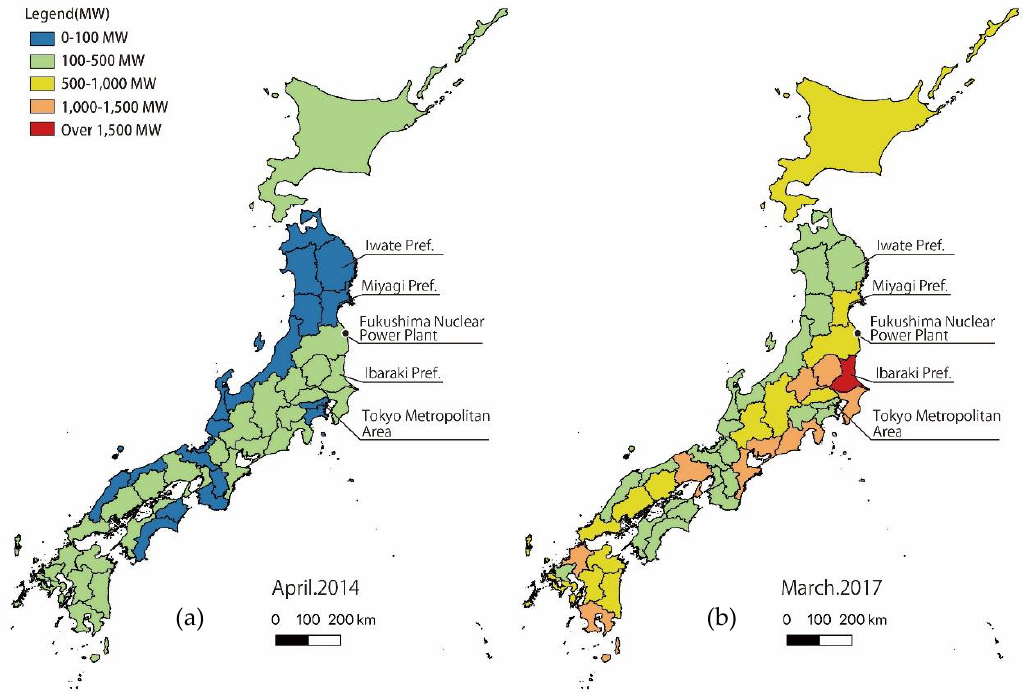
Figure 5. Changes in the cumulative number of solar power facilities in 2014 ( a ) and 2017 ( b ). Source: Collected and processed by the authors.